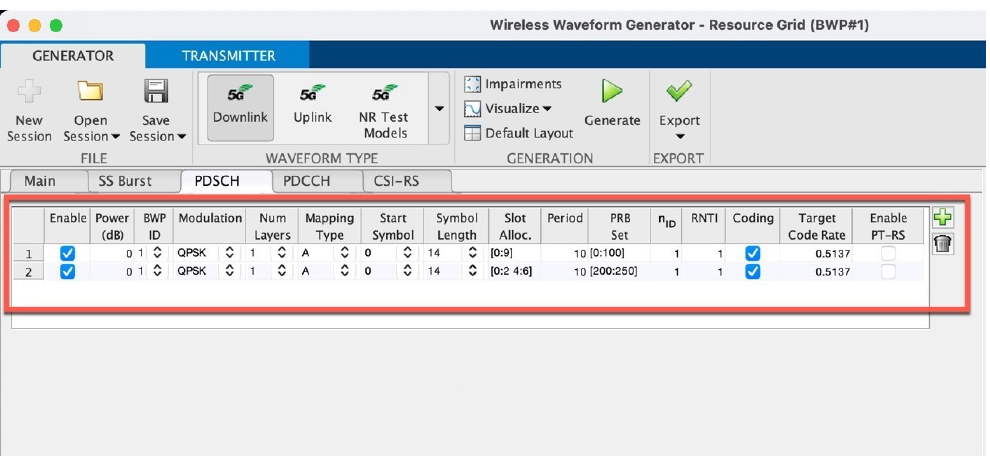
Figure A2. Parameter settings for the PDSCHs.